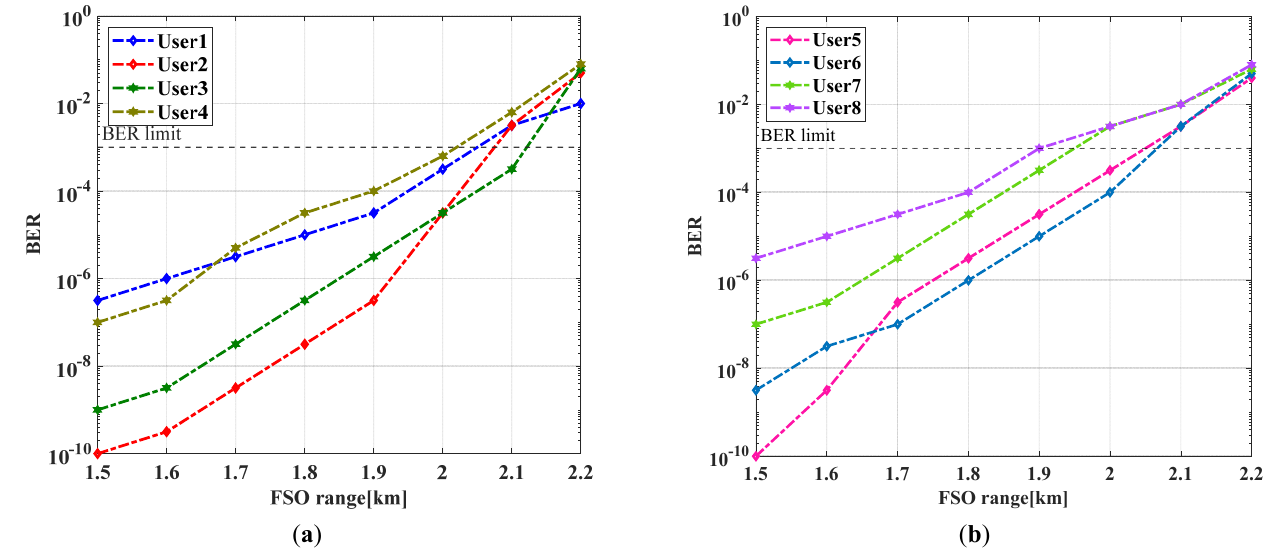
Figure 4. Measured BER at fixed MMF link of 100 m under clear air conditions. ( a ) Users 1 to 4 operating on Donut mode 0, ( b ) users 5 to 8 operating on Donut mode 1.